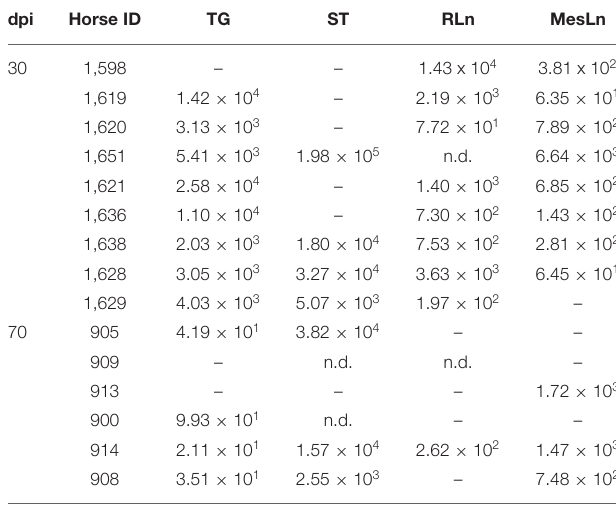
TABLE 2 | Distribution of EHV-1 genomic DNA 30 and 70 days post infection (dpi) (EHV-1 gDNA copies/10 6